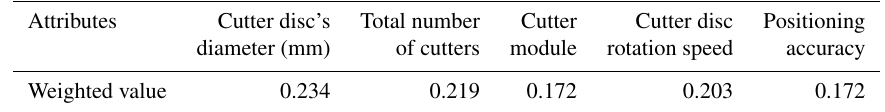
Table 5. PIW weighted values of the cutter disc module attributes.